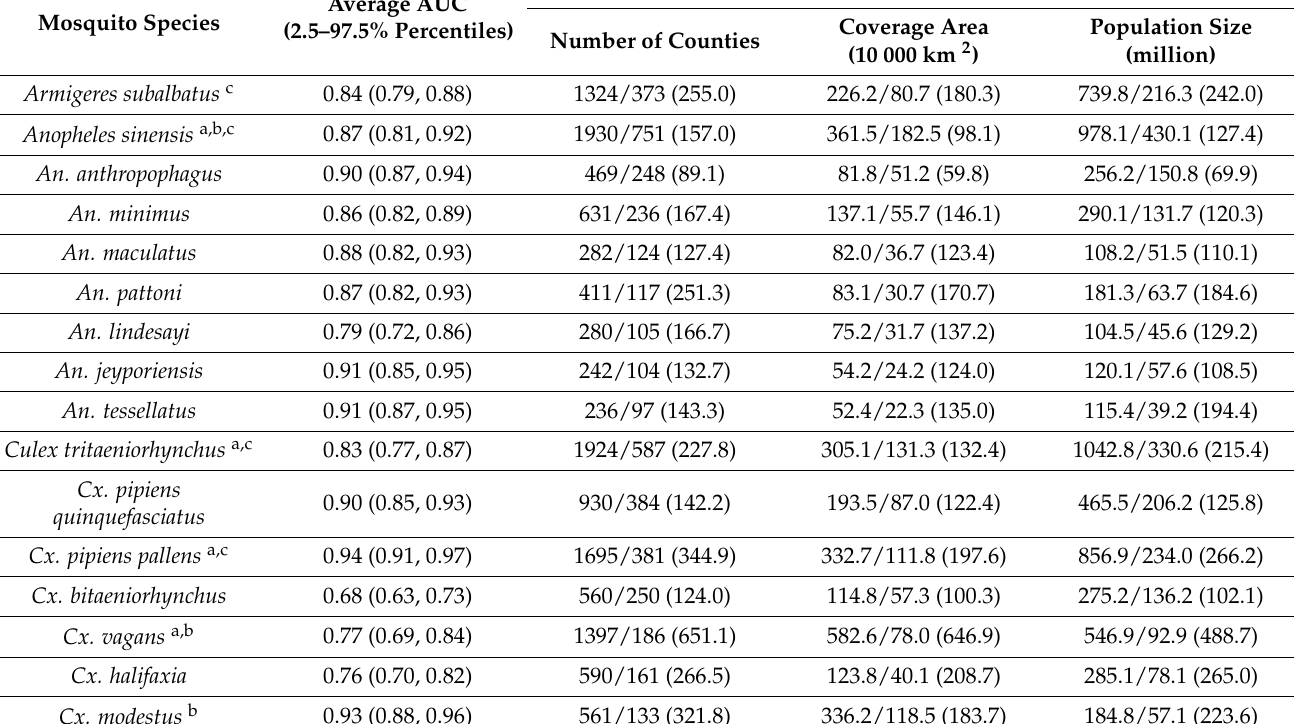
Table 1. The average testing areas under curve (AUC) of the BRT models and predicted numbers, coverage areas and population sizes of affected counties for the 26 most prevalent mosquito species in